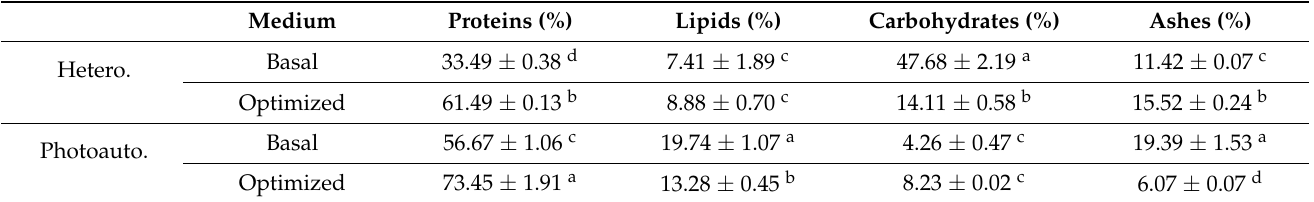
Table 8. Proximate composition of biomass with hetero- and photoautotrophic basal and optimized media. Proteins, lipids, carbohydrates, and ashes are presented as the percentage of the biomass dry weight. Different letters indicate significant differences between media. Values are given as means ± standard deviation ( n = 3). Proteins (%) Lipids (%) Carbohydrates (%) Ashes (%)